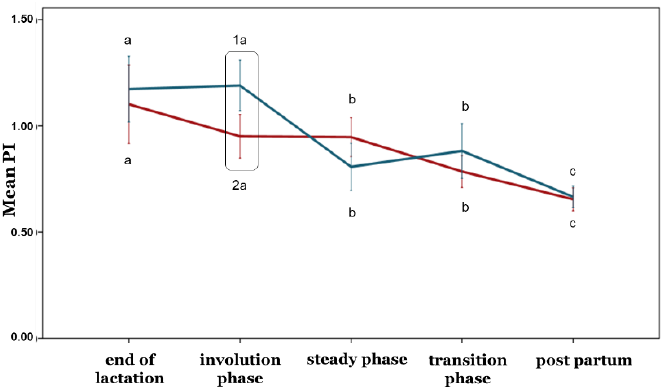
Figure 4. Pulsatility index changes among the periods and between the ewe groups ( p ≤ 0.05). The different letter indicators (a, b, c) represent statistically significant differences between the periods, while the different number indicators (1, 2) represent statistically significant differences between the ewe groups in the same period. The green line represents the ewe group with healthy udders, while the red represents the ewe group with subclinical mastitis.